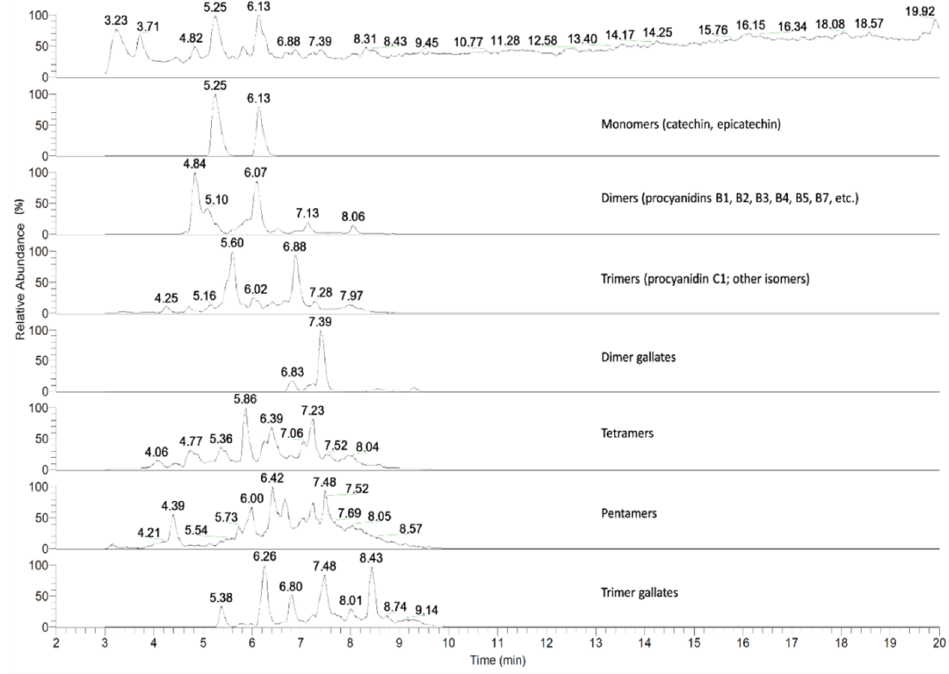
Figure 1. Liquid Chromatography-Mass Spectrometry (LC-MS) chromatogram of grape seed extract shows dimer, trimer, and tetramer of proanthocyanidin and its gallates. Numbers above the peaks denote the retention times.